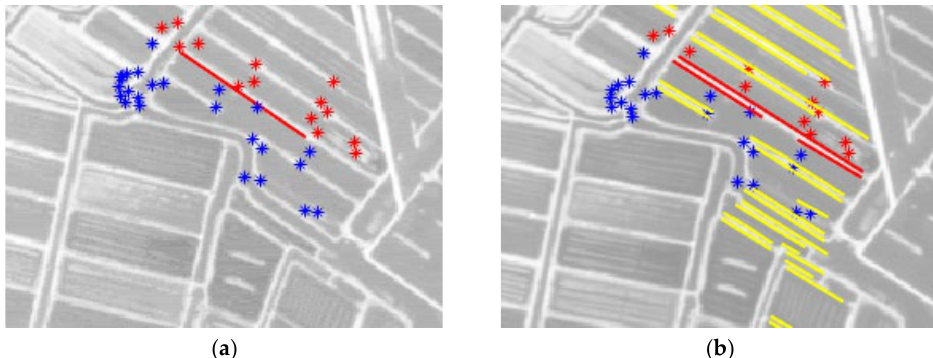
Figure 4. Corresponding points constraint. ( a ) Reference image; ( b ) search image. The blue points and the red points are the corresponding points on both images, respectively, on either side of the reference line. The red lines in ( b ) are the candidate lines to be retained as satisfying the corresponding points constraint, and the yellow lines are those filtered out by the corresponding points